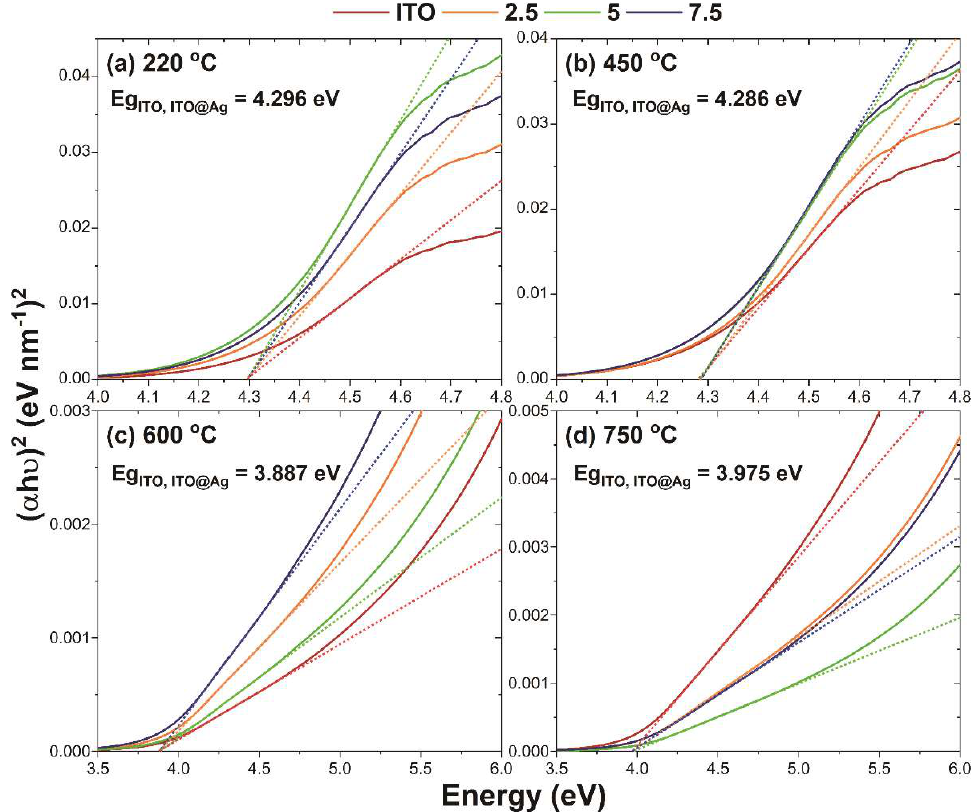
Figure 6. Tauc plot from absorption spectra of ITO and ITO@Ag thin films according to the ther- mal−treatment temperature ( a ) 220 °C, ( b ) 450 °C, ( c ) 600 °C, and ( d ) 750 °C. The straight dotted line thermal − treatment temperature ( a ) 220 ◦ C, ( b ) 450 ◦ C, ( c ) 600 ◦ C, and ( d ) 750 ◦ C. The straight extrapolation determines the bandgap. dotted line extrapolation determines the